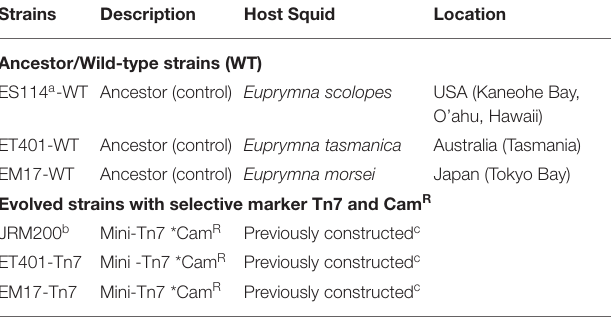
TABLE 1 | Vibrio fischeri strains used in the study. Strains